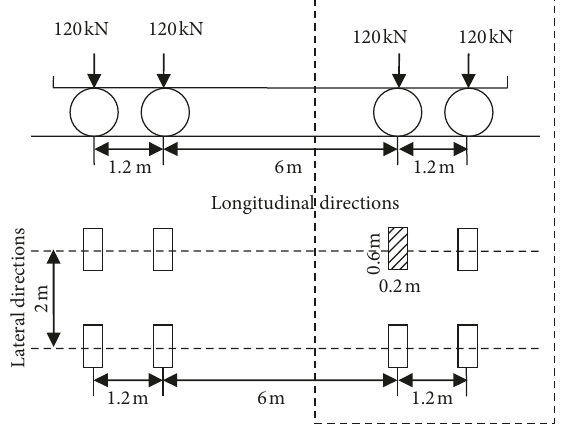
Figure 6: Standard fatigue load